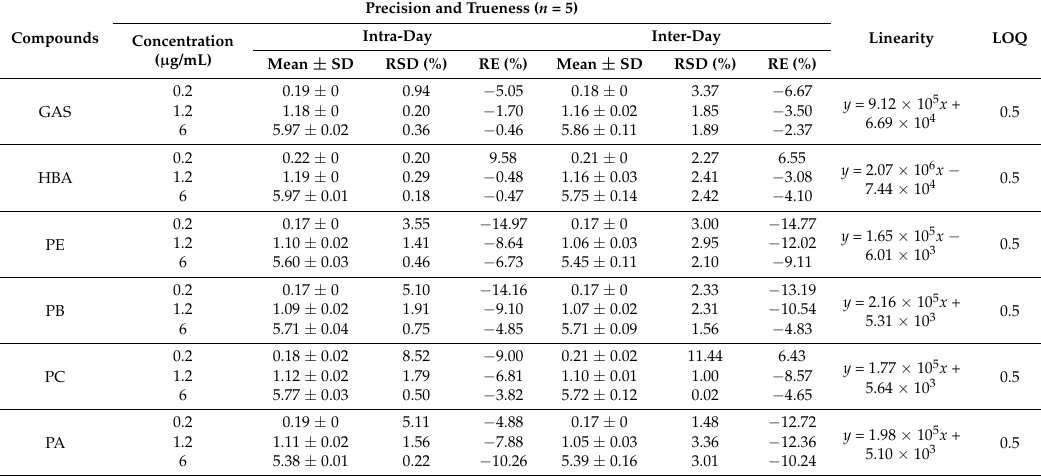
Table 1. Intra- and inter-day precision and trueness, linearity and limit of quantitation (LOQ) of gastrodin (GAS), gastrodigenin (HBA), parishin E (PE), parishin B (PB), parishin C (PC) and parishin (PA). Precision and Trueness ( n = 5) Compounds